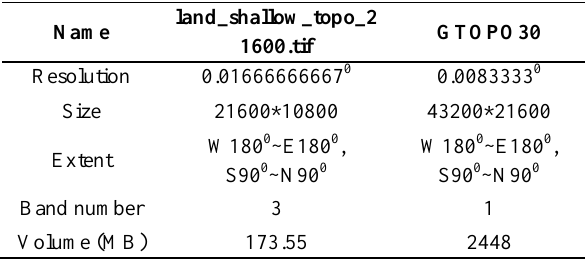
Table 2. Basic information of experimental data